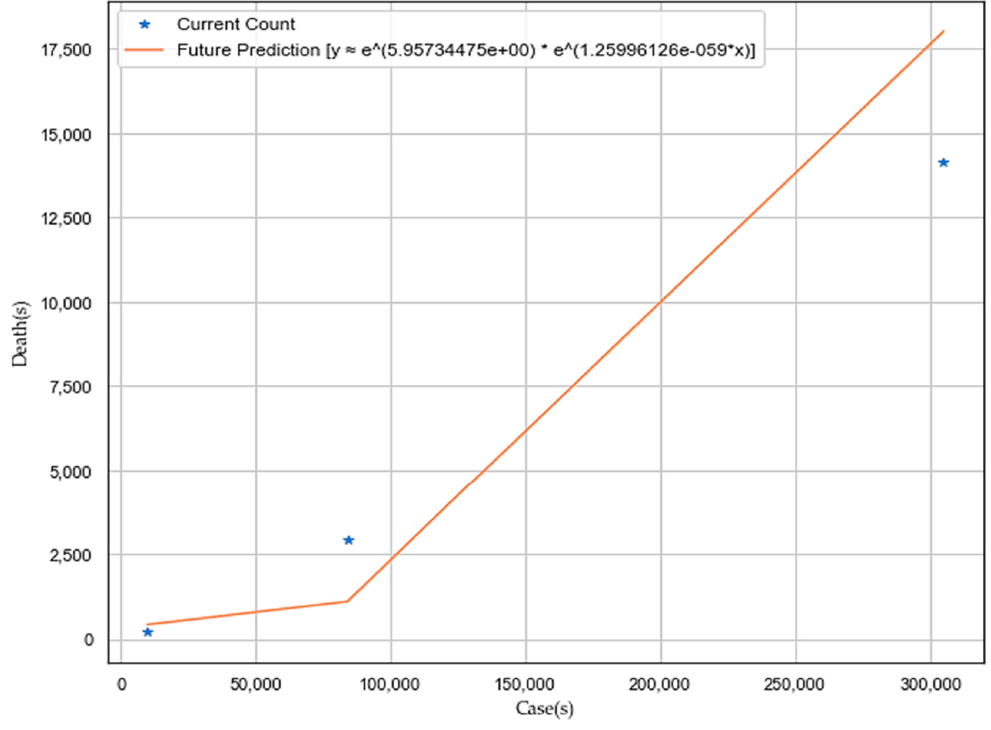
Figure 7. Exponential regression plot to show death increases with number of cases.